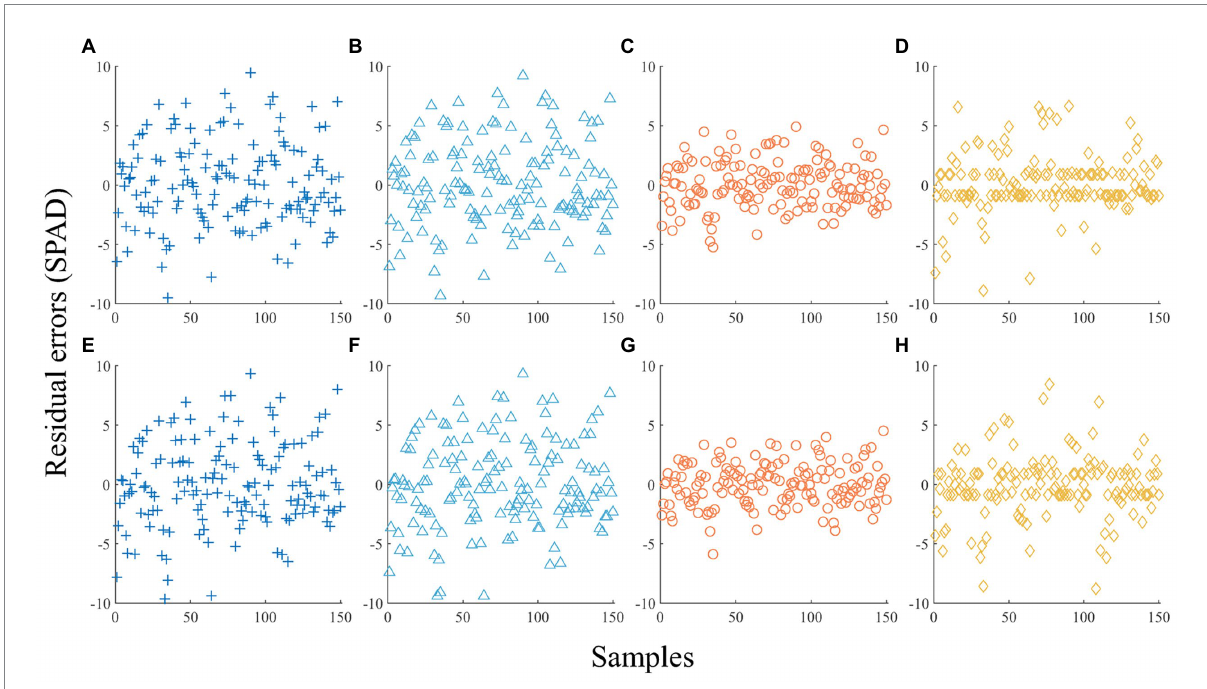
FIGURE 6 Estimated residuals of modeling samples using different images and algorithms with shade variables. (A) RGB-based LMM. (B) RGB-based OLR. (C) RGB-based RF. (D) RGB-based SVR. (E) MS-based LMM. (F) MS-based OLR. (G) MS-based RF. (H) MS-based SVR.